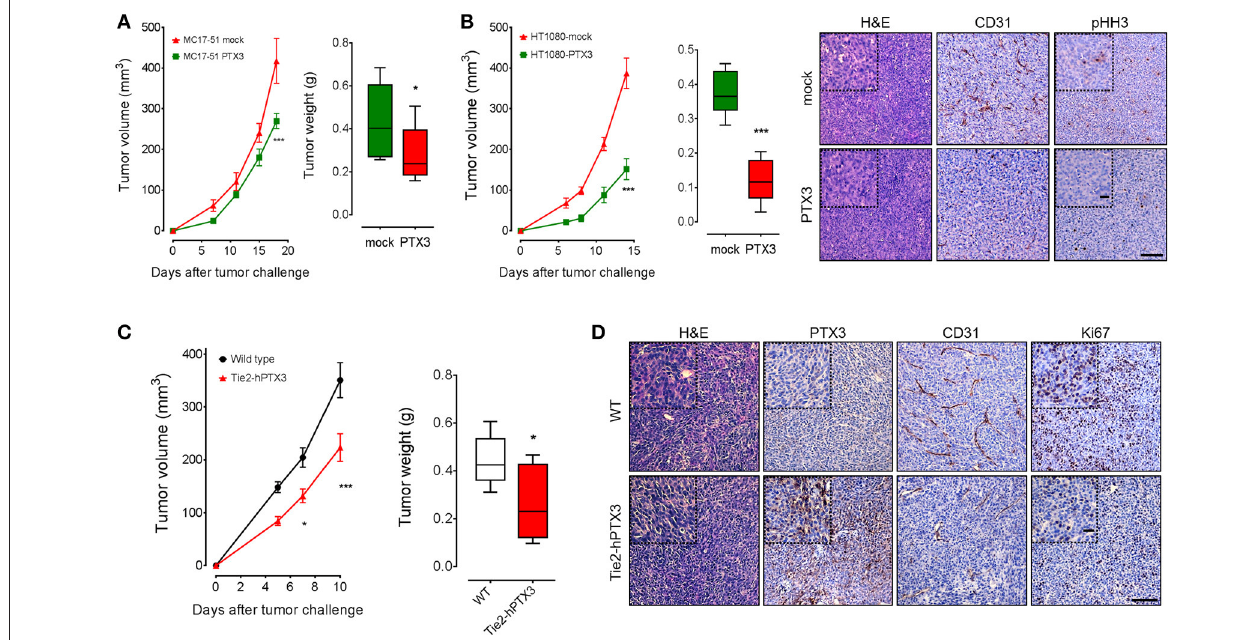
FIGURE 3 | PTX3 impairs the growth of fibrosarcoma cells in vivo . Mock and PTX3-transfected MC17-51 and HT-1080 cells were injected s.c. in syngeneic C57BL/6 (A) or immune-compromised NOD/Scid (B) mice ( n = 10 mice/group), respectively. Tumors were measured with caliper at different time points and weighted at the end of the experiment. HT-1080 tumors were stained for phospho-Histone H3 (pHH3) and CD31 (main scale bar, 200 µ m; magnification insert: scale, bar 50 µ m). (C) Wild type MC17-51 cells were injected s.c. in wild type (C57BL/6) and transgenic (Tie2-hPTX3) mice ( n = 10 mice/group). (D) Explanted tumors were immunostained with anti-PTX3, anti-CD31 and anti-Ki67 antibodies (main scale bar, 200 µ m; magnification insert: scale bar 50 µ m). Data are the mean ± S.E.M of 10 tumors per group. (* P < 0.05; *** P <